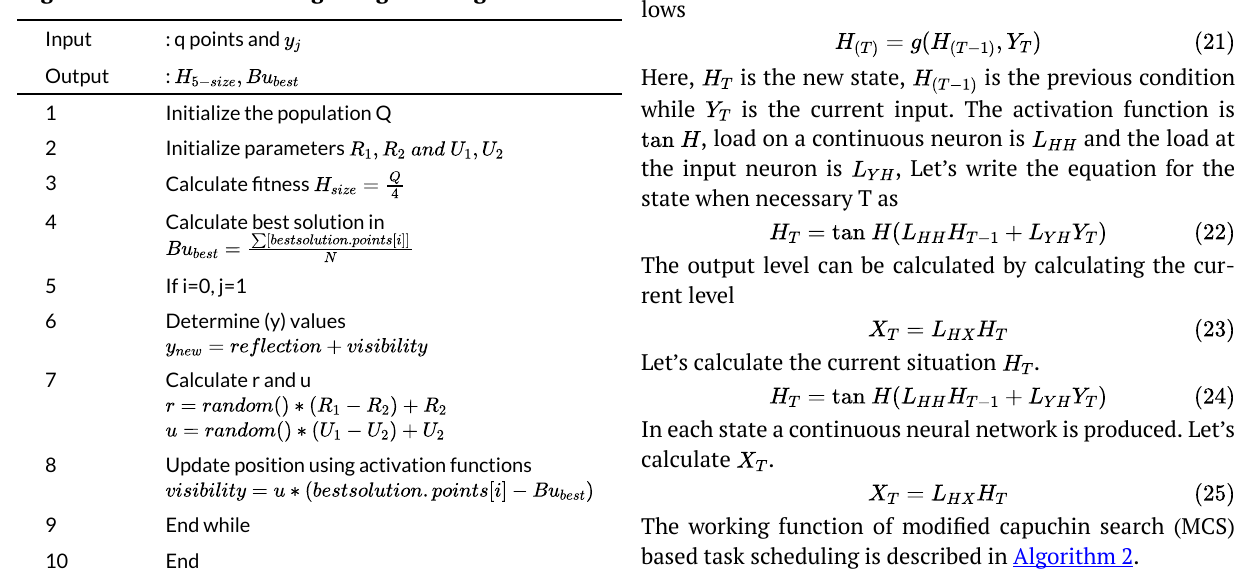
Algorithm 1. Task clustering using ICFO